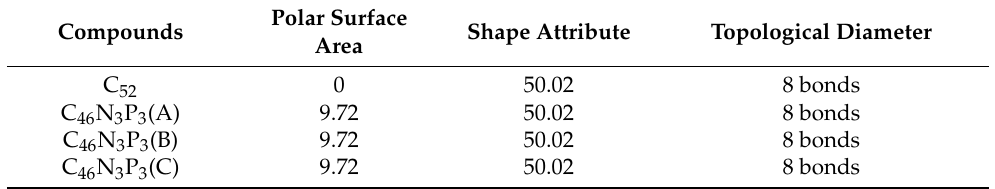
Table 12. Topological characterization of the fullerenes.